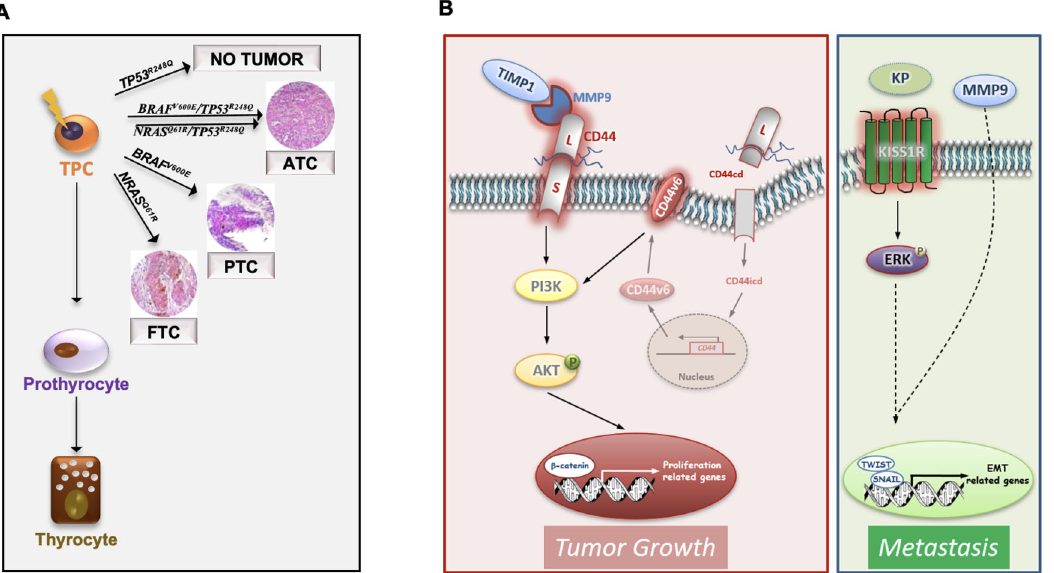
Fig. 7 | Model of TC tumorigenesis and progression. A Schematic model illus- trating that the most common TC genetic alterations ( BRAF V600E , NRAS Q61R , BRAF V600E /TP53 R248Q and NRAS Q61R /TP53 R248Q ) in thyroid progenitor cell (TPC) recapi- tulatethedifferentTChistotypes(FTC,PTCandATC).Ofnote TP53 R248Q aloneisnot required for TC initiation. B Model of ternary complex (TIMP1/MMP9/CD44) and KISS1R driven pathways in engineered D22 TPCs. TIMP1 and pro-MMP9